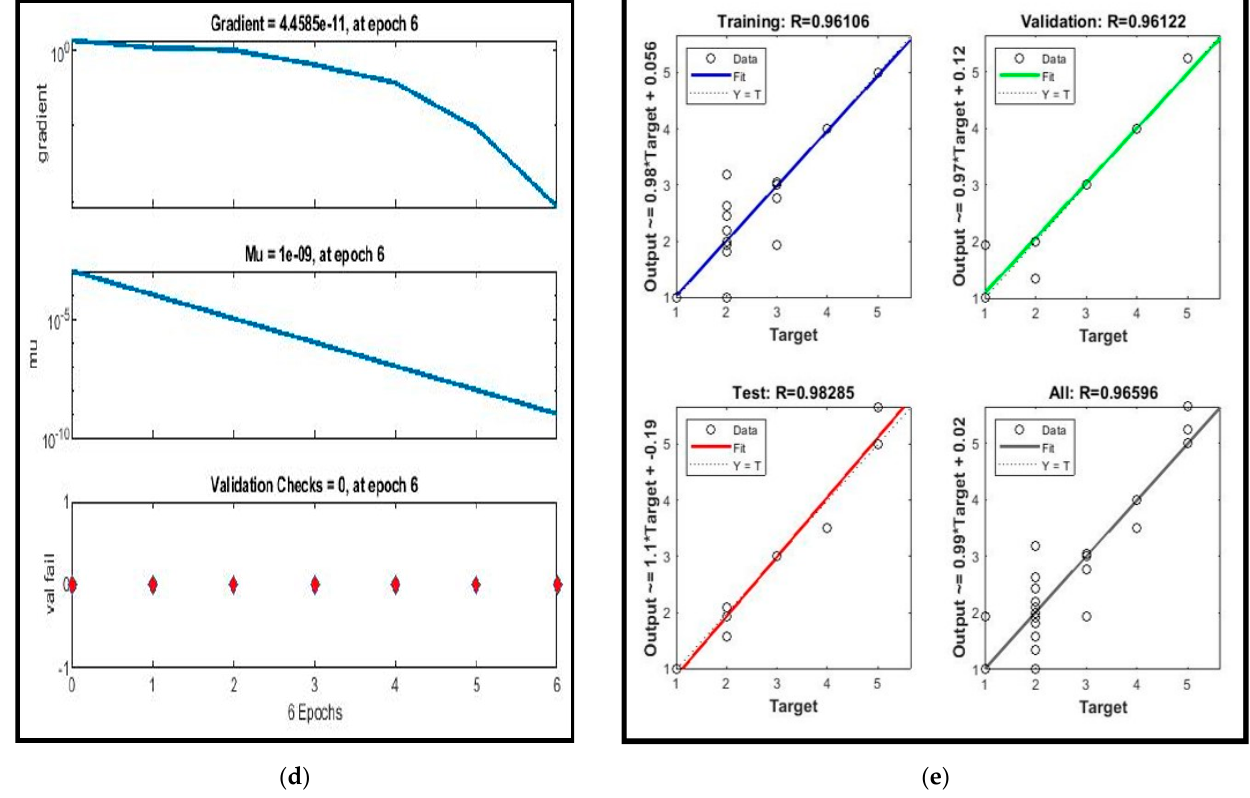
Figure 8. ANN model for LSM: ( a ) mole architecture; ( b ) model’s define parameters; ( c ) model performance (training); ( d ) model training state; ( e ) regression plot (training, test, validation, and overall). The network parameters window displays the model’s training process (Figure